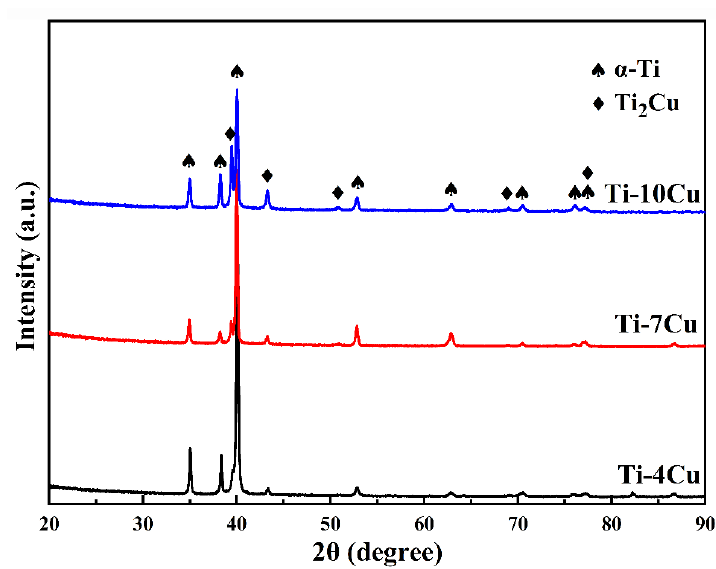
Figure 3. XRD patterns of the as-cast Ti-xCu